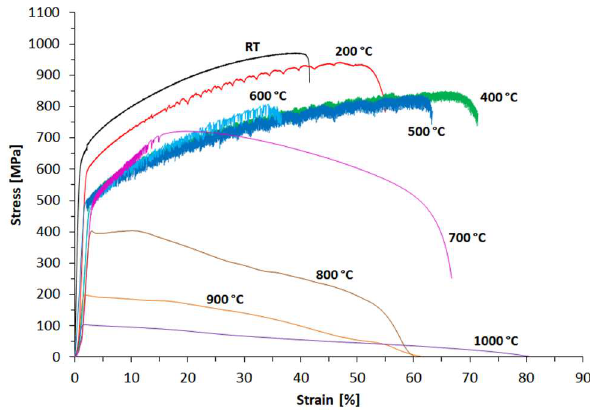
Figure 3. Stress-strain curves obtained from Inconel 625 tensile tests at room temperature (RT) until 1000 °C.